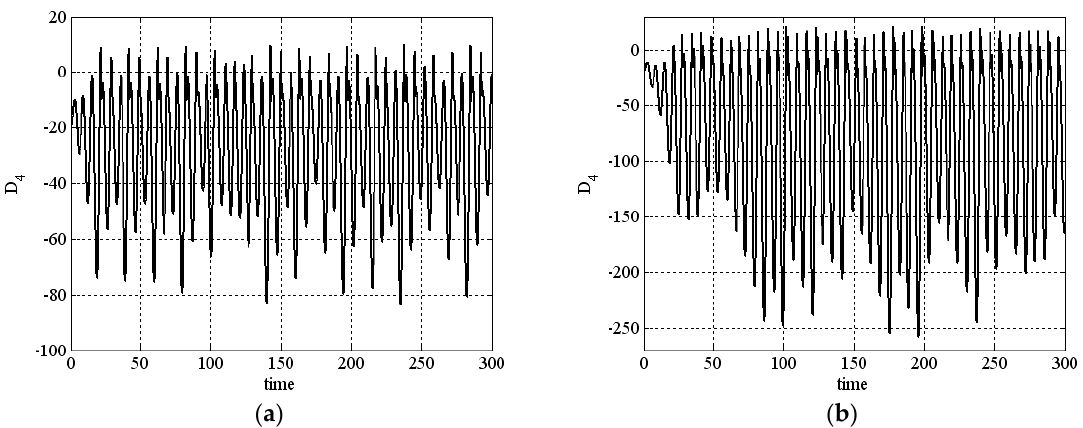
Figure A2. Values of D 4 (see (6)) when ( a ) a = 0.25, b = 3, c = 0.5, d = 0.05, b 1 = 0.1, b 2 = − 0.1, b 3 = b 4 = 0.1; ( b ) a = 0.25, b = 3, c = 0.5, d = 0.05, b 1 = 1.2, b 2 = − 0.1, b 3 = b 4 = 0.1.